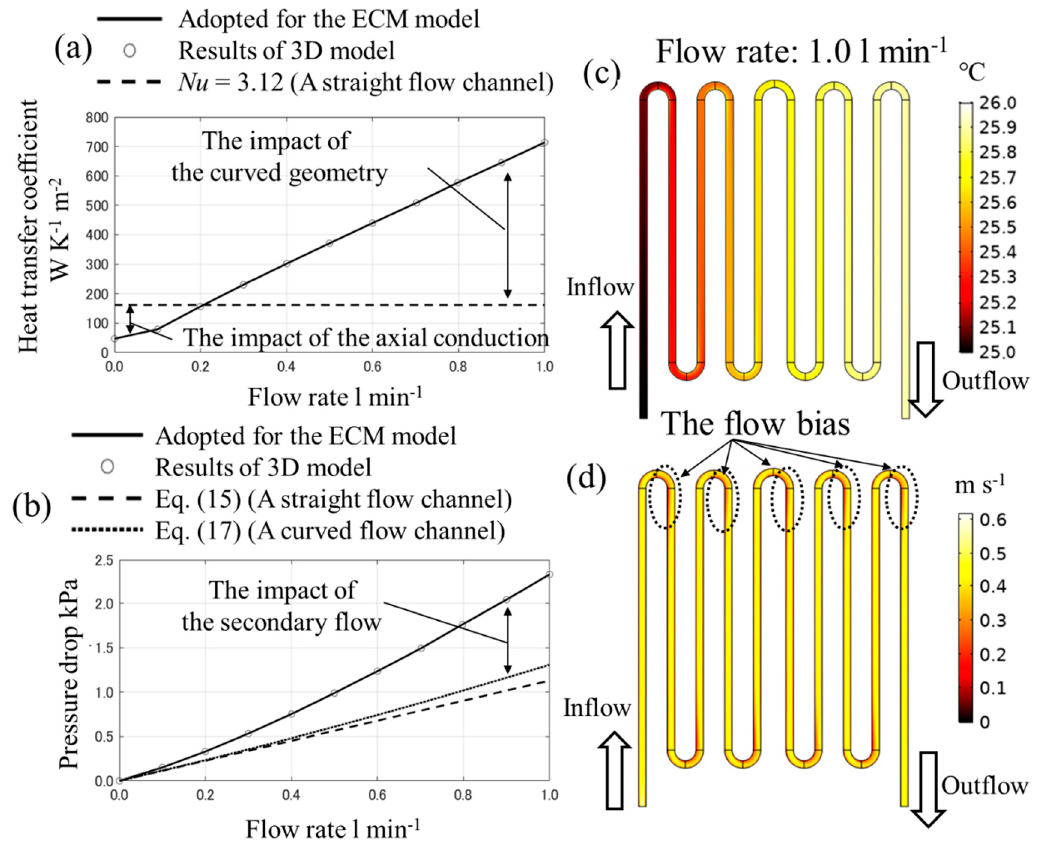
Figure 8. The relationship ( a ) between the flow rate and the heat transfer coefficient, ( b ) it between the flow rate and the pressure drop, ( c ) the temperature distribution and ( d ) the velocity magnitude distribution in the z-directional center cross-section of the flow channel when the flow rate is 1.0 l·min − 1 .